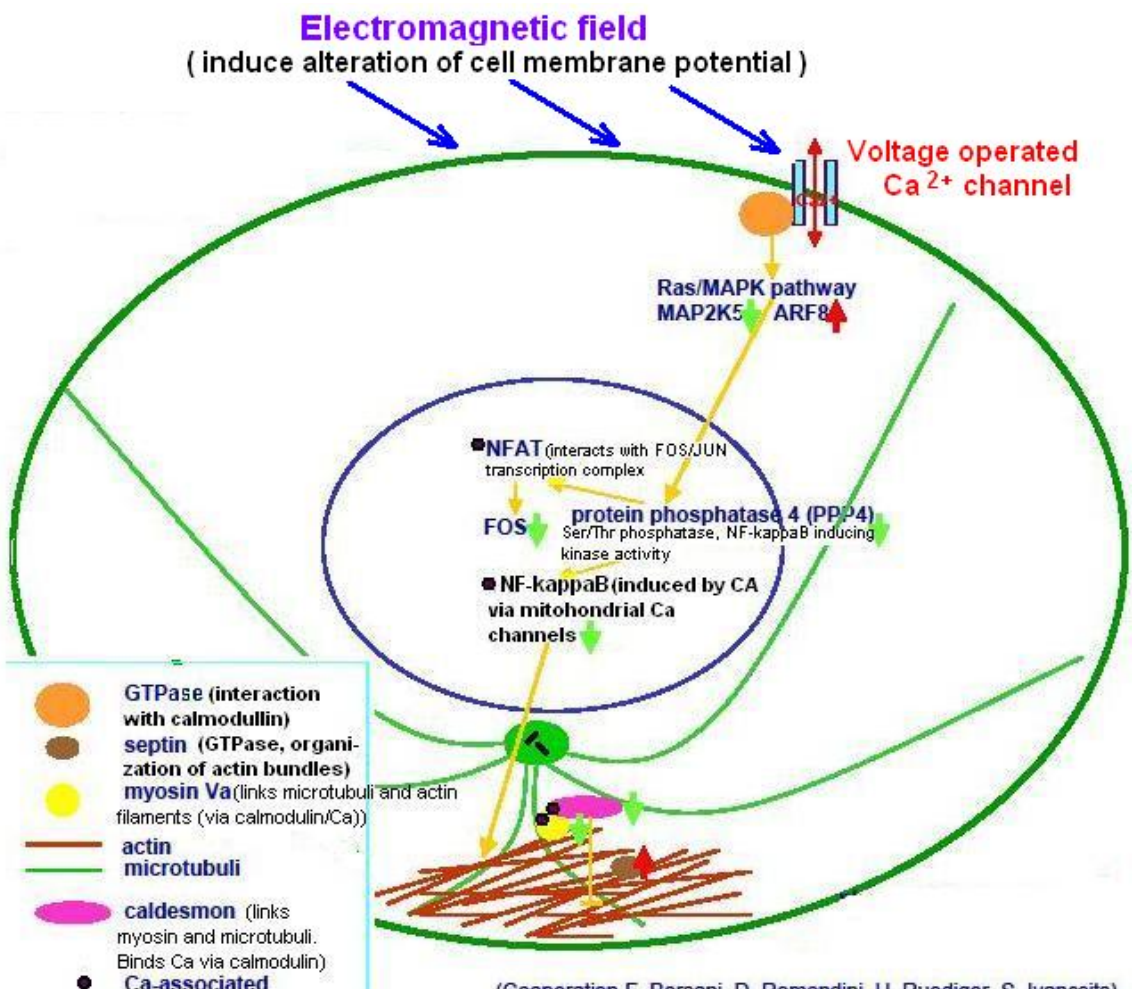
Figure 7. Possible mechanisms of the extremely low frequency EMF effects on transcription through Ca 2+ -operated pathways. (From [77], with modifications; reproduced with the kind permission of Dr.